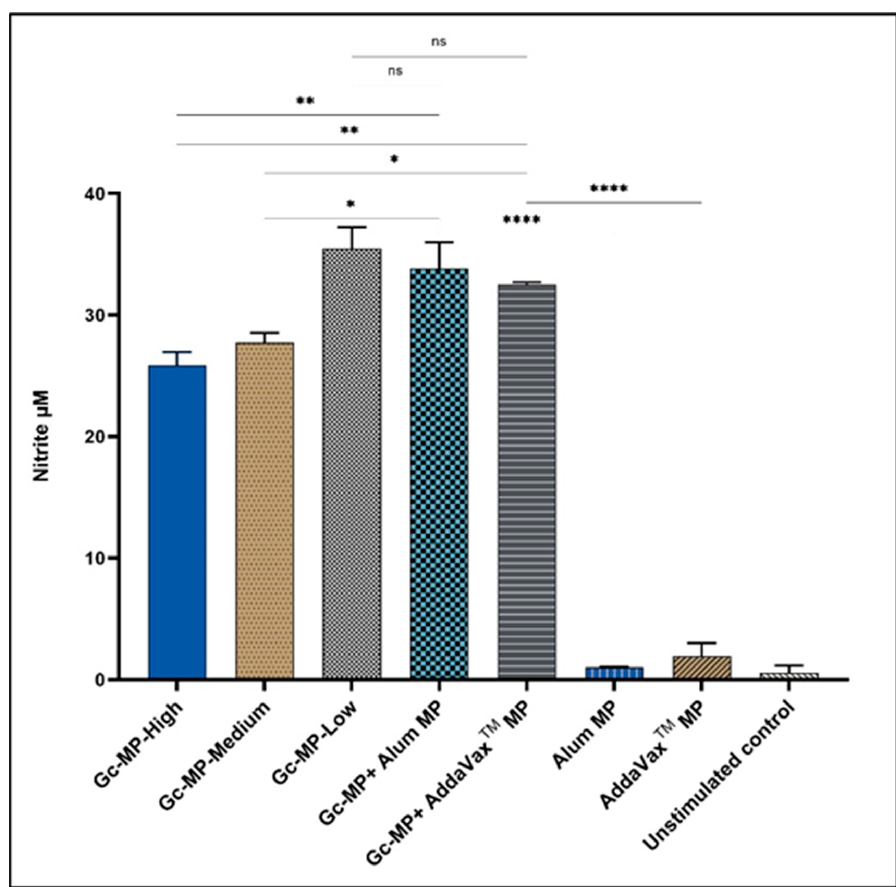
Figure 2. Nitric oxide release from GFP-LC3-RAW264.7 macrophages induced with gonococci vaccine microparticles (Gc-MP) with or without adjuvant MP. Macrophages were adjusted to 1 × 10 6 cells/mL and induced with various doses of vaccine microparticles for 18 h. Gonorrhea vaccine microparticles Gc-MP-High 100 µ g/mL, Gc-MP-Medium 50 µ g/mL, Gc-MP-Low 25 µ g/mL, Gc-MP with Alum microparticles (Gc-MP+ Alum MP) 50 µ g/mL of each, Gc-MP with AddaVax™ microparticles (Gc-MP+ AddaVax™ MP) 50 µ g/mL of each. Unstimulated cells, Alum MP, and AddaVax™ MP alone were used as controls. Nitrite accumulation in supernatants was measured using the Griess reaction. All the experiments were repeated three times. Data is expressed as mean ± SD, Ordinary one-way ANOVA test, post-hoc Tukey’s multiple comparison test. ns, no significant, * p < 0.05 significant, ** p < 0.01 very significant, **** p < 0.001 extremely